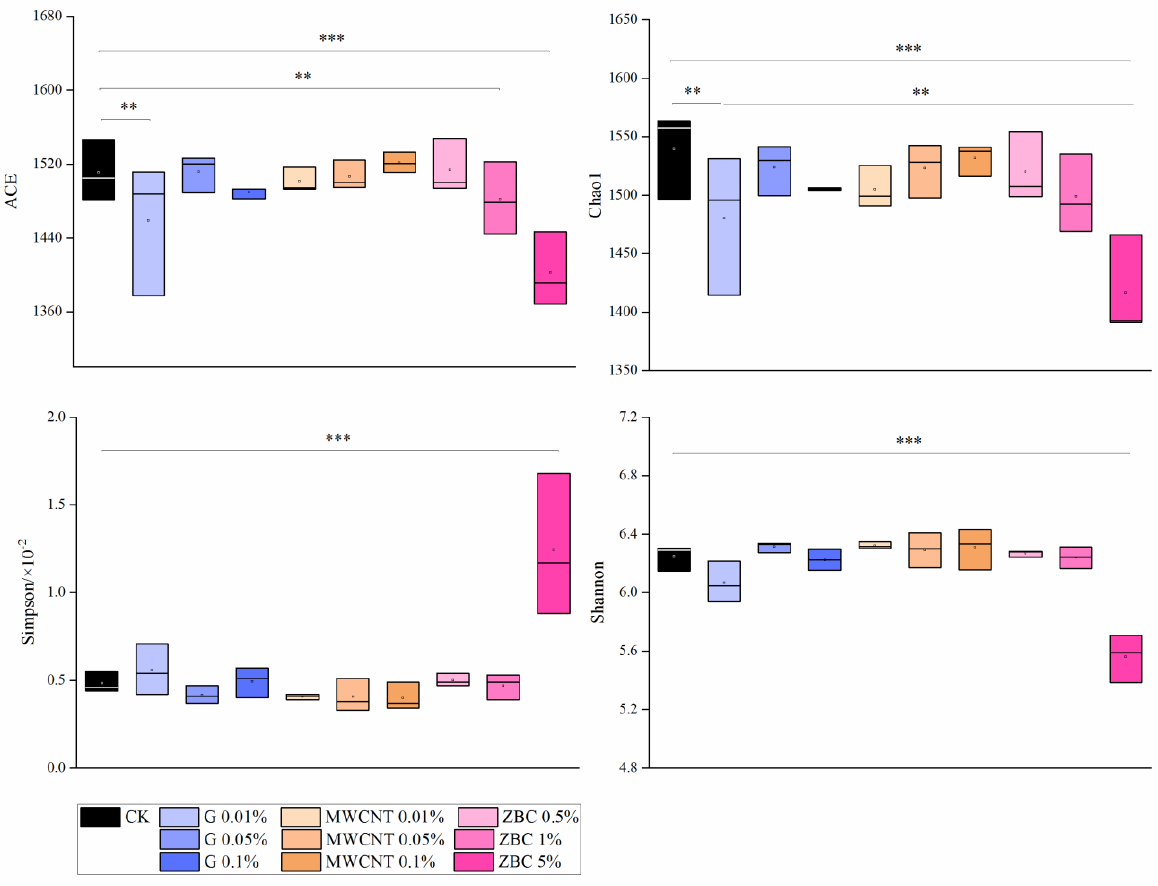
Figure 3. Effects of carbonaceous amendments on α -diversity index. (** p < 0.01, *** p < 0.001, and the same applies hereafter.)